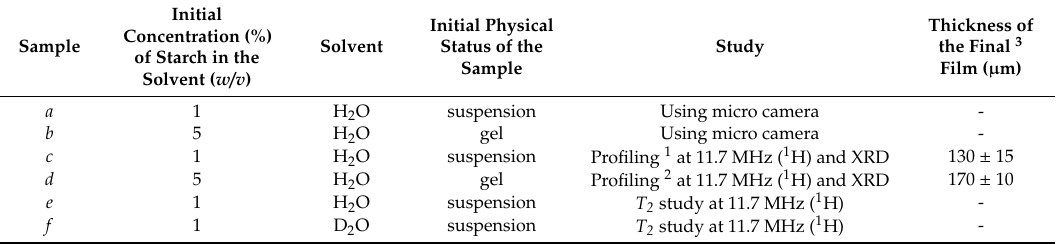
Table 1. Di ff erent starch samples prepared using H 2 O or D 2 O as a solvent. Glycerol was added as a plasticizer (20 g / 100 g starch) to prepare each